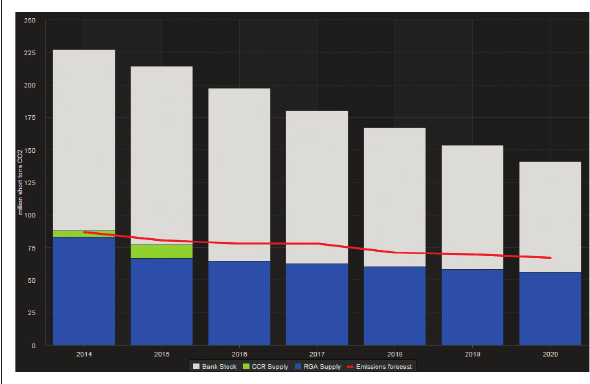
Source : Figure generated in Thomson Reuters Eikon 2016 FIGURE 3: Line graph showing the forecasted emissions by power producers under the Regional Greenhouse Gas Initiative scheme within a composite bar graph showing bank stocked RGAs, RGA supply and cost containment reserve supply in millions of short